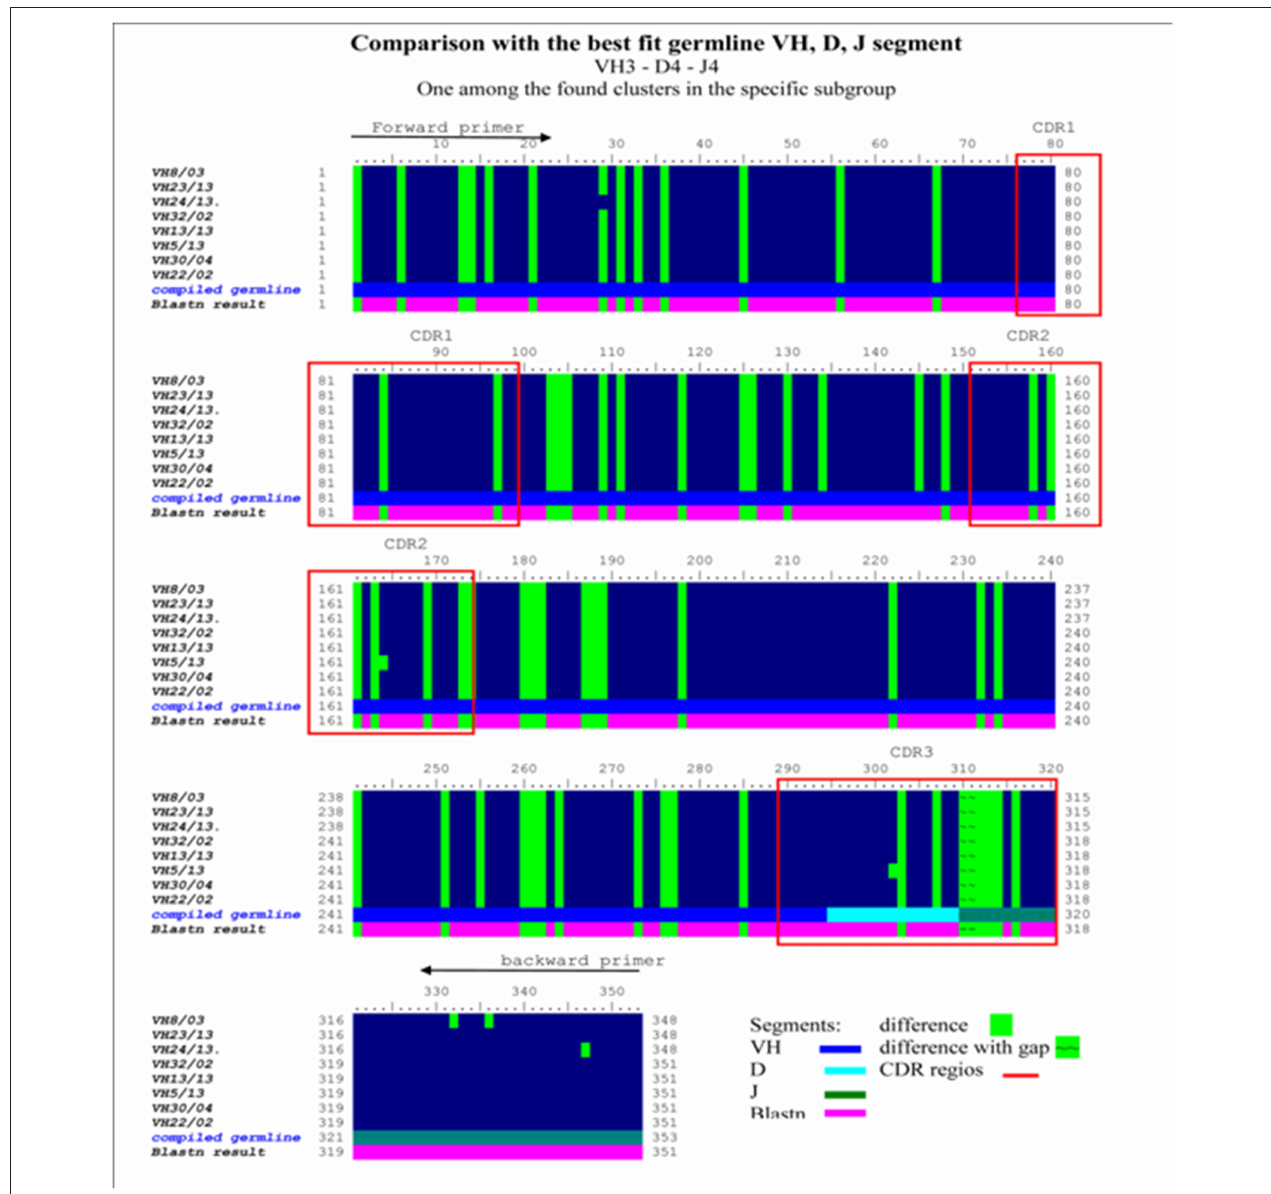
FIGURE 6 | Homology ribbon representing comparative DNA sequence analysis results in the representative VH3 No I cluster. This is a comparison block that summarizes the alignment of previously defined, overrepresented Ig VH3 family cluster NoI immunoglobulin-variable region genes from invasive breast carcinoma with medullary features, defining the consensus DNA sequence of interest. Comparative DNA sequence analysis was performed with BioEDit, VectorNTI 11, and relevant databases (IMGT, Blastn) were used. Framework (FR1, FR2, FR3, FR4) and complementary determining (CDR1, CR2, CDR3) (red bordered squares) DNA regions show extremely high homology in this overrepresented cluster. Comparison with the best fit germline VH, D, J segment in the VH3/I subgroup was performed. Difference to compiled germline is shown with green label, while alteration found to blastn results are depicted with a purple lane. Consensus sequences defined in this homology ribbon alignment serve as control in the melanoma antibody repertoire